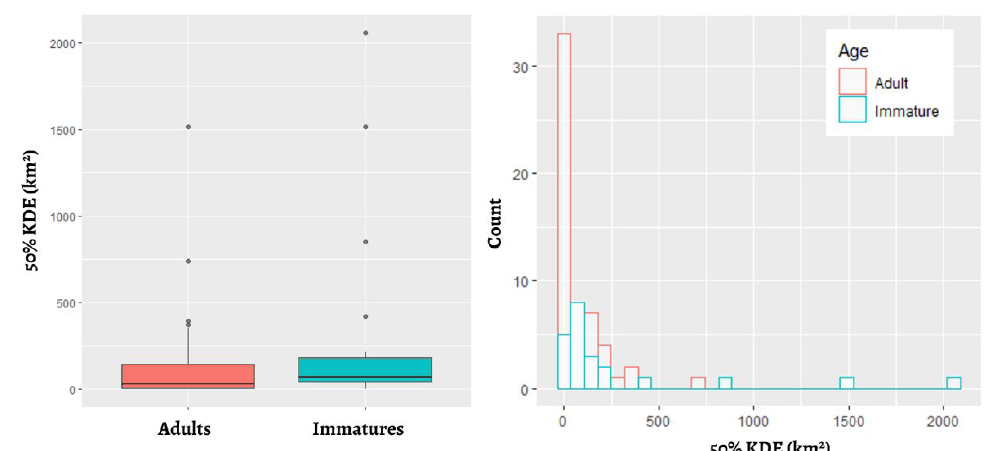
Figure 3. Comparison between age (immatures/adults) based on home range size estimations (MCP, 95% KDE, 75% KDE and 50% KDE). Boxplots are shown on the left (horizontal line—median; vertical line—minimum and maximum values without outliers; points—outliers). Histograms are shown on the right.